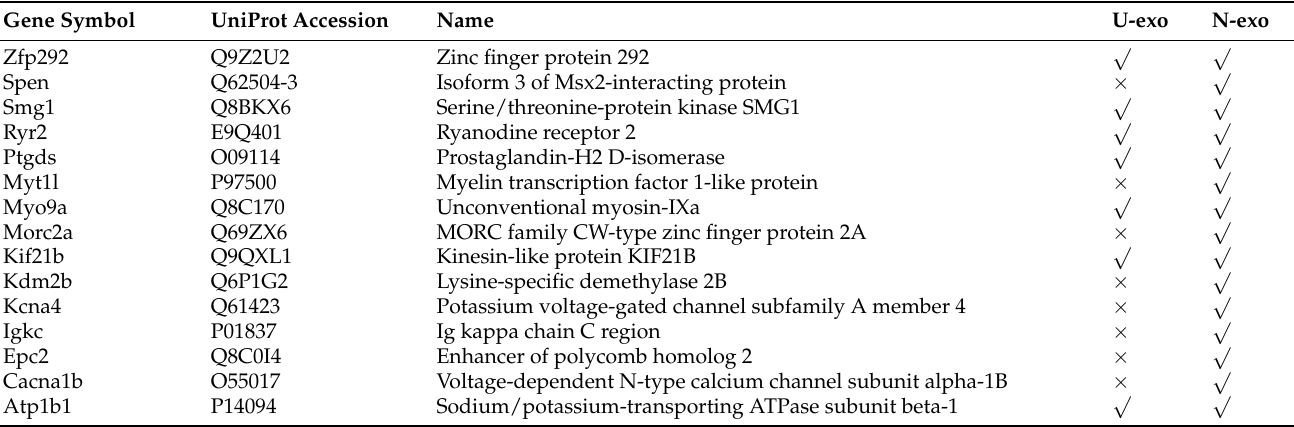
Figure 2. The comparison of the different proteins we identified in U-exo and N-exo. ( A ) Venn diagram reflecting the identified different proteins in U-exo and N-exo and ( B ) corresponding proteins. U-exo: urine exosomes. N-exo: neuron-derived exosomes. Table 3. Neuron markers in U-exo and